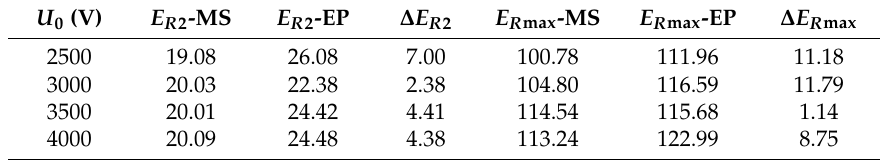
Figure 8. R (resistance)–q (absorption energy) curves of two samples under different U 0 . Table 3. Energy differences between the two samples at R 2 and R max (the unit of energy is mJ).